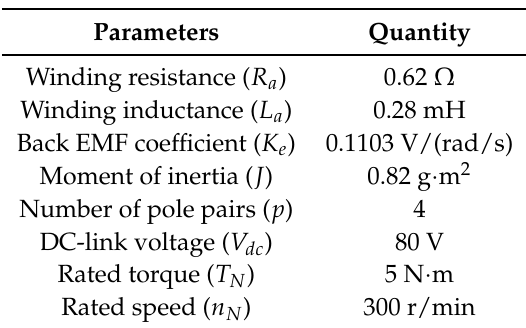
Figure 9. Photograph of the experimental setup. Table 2. Motor